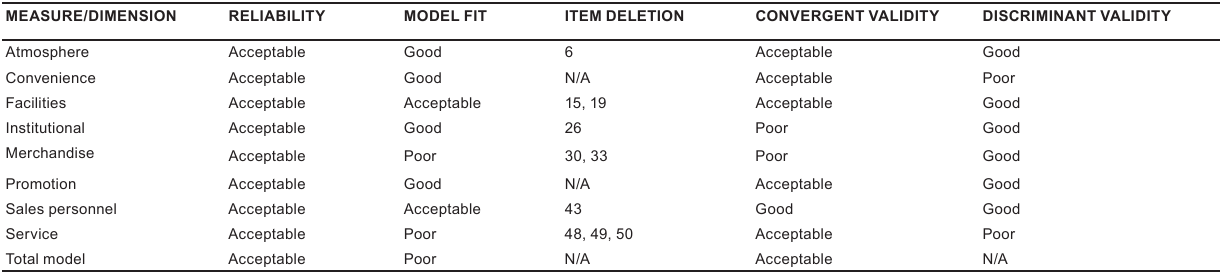
TABLE 14 Summary of conclusions on model fit, reliability and validity of the individual dimensions and Simplified Model of Apparel Store